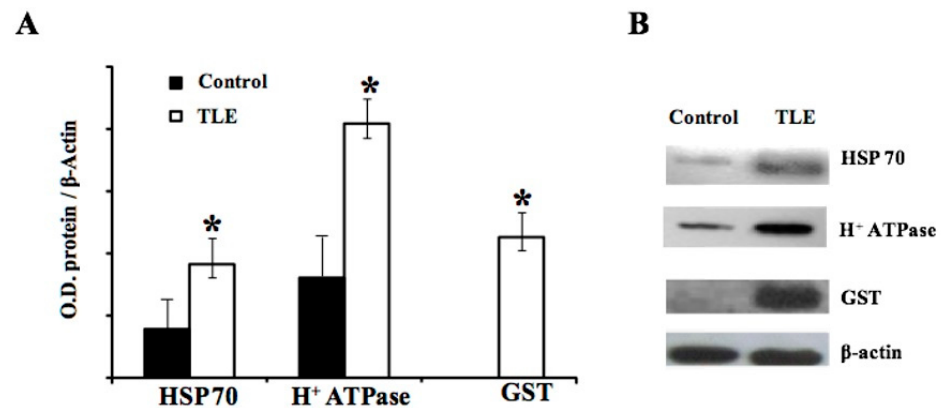
Figure 4. Western blot analysis to validate the differential displays for HSP70, H + -ATPase, and GST in MTLE and control samples. β -actin was used as an endogenous control for protein expression. Densitometry analysis was performed using Densirag software. ( A ) Band densities of samples (control, n = 4; and MTLE, n = 5) were digitized to measure optical density (mean ± SD). ( B ) A representative Western blot of HSP70, H + -ATPase, and GST expression.